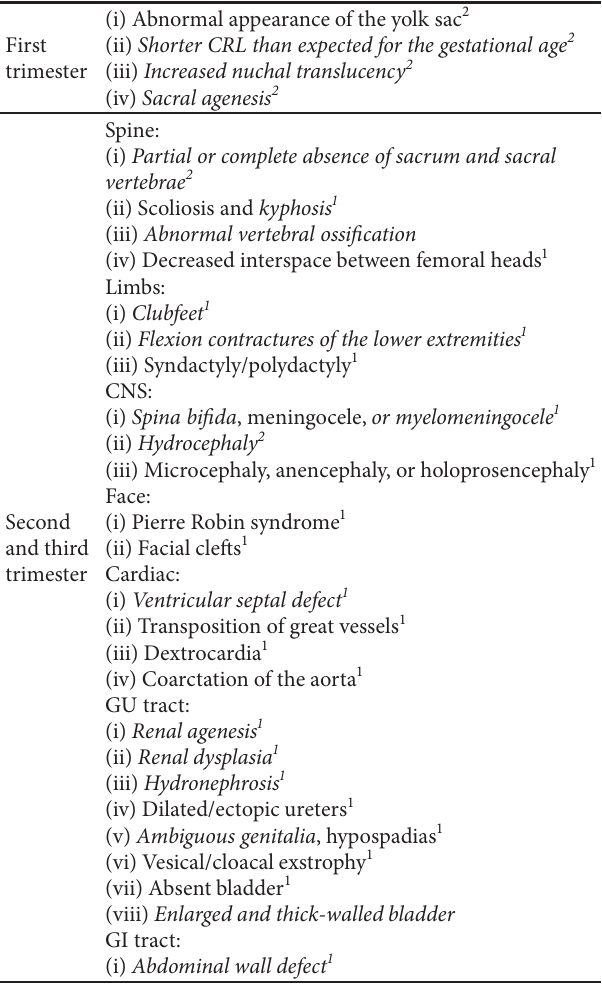
Table 1: Prenatal ultrasound features of caudal regression syn- drome: the findings observed in our series are